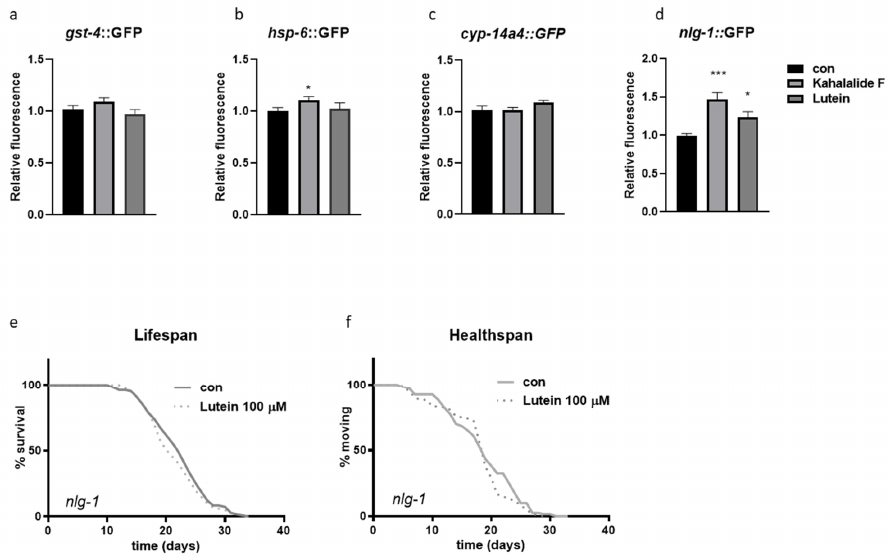
Figure 6. nlg -1 induction mediates lutein’s beneficial effects. ( a – d ) gst-4, hsp-6, cyp-14A4 and the nlg-1 expression with transcriptional reporter GFP strains. Asterisks (*) denote statistical significance compared to control. Unpaired t -test: * p value ≤ 0.05, *** p value ≤ 0.001. ( e ) Lifespan, shown as % of surviving animals over time, and ( f ) healthspan, calculated as % of moving animals, among surviving nematodes, over time in nlg-1 knockout strain upon lutein treatment.